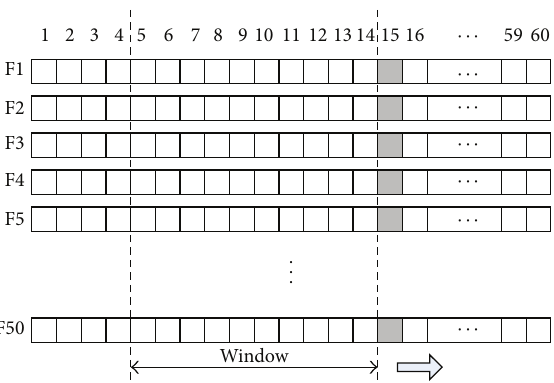
Figure 11: Shifting window in covariate shift adaptation.